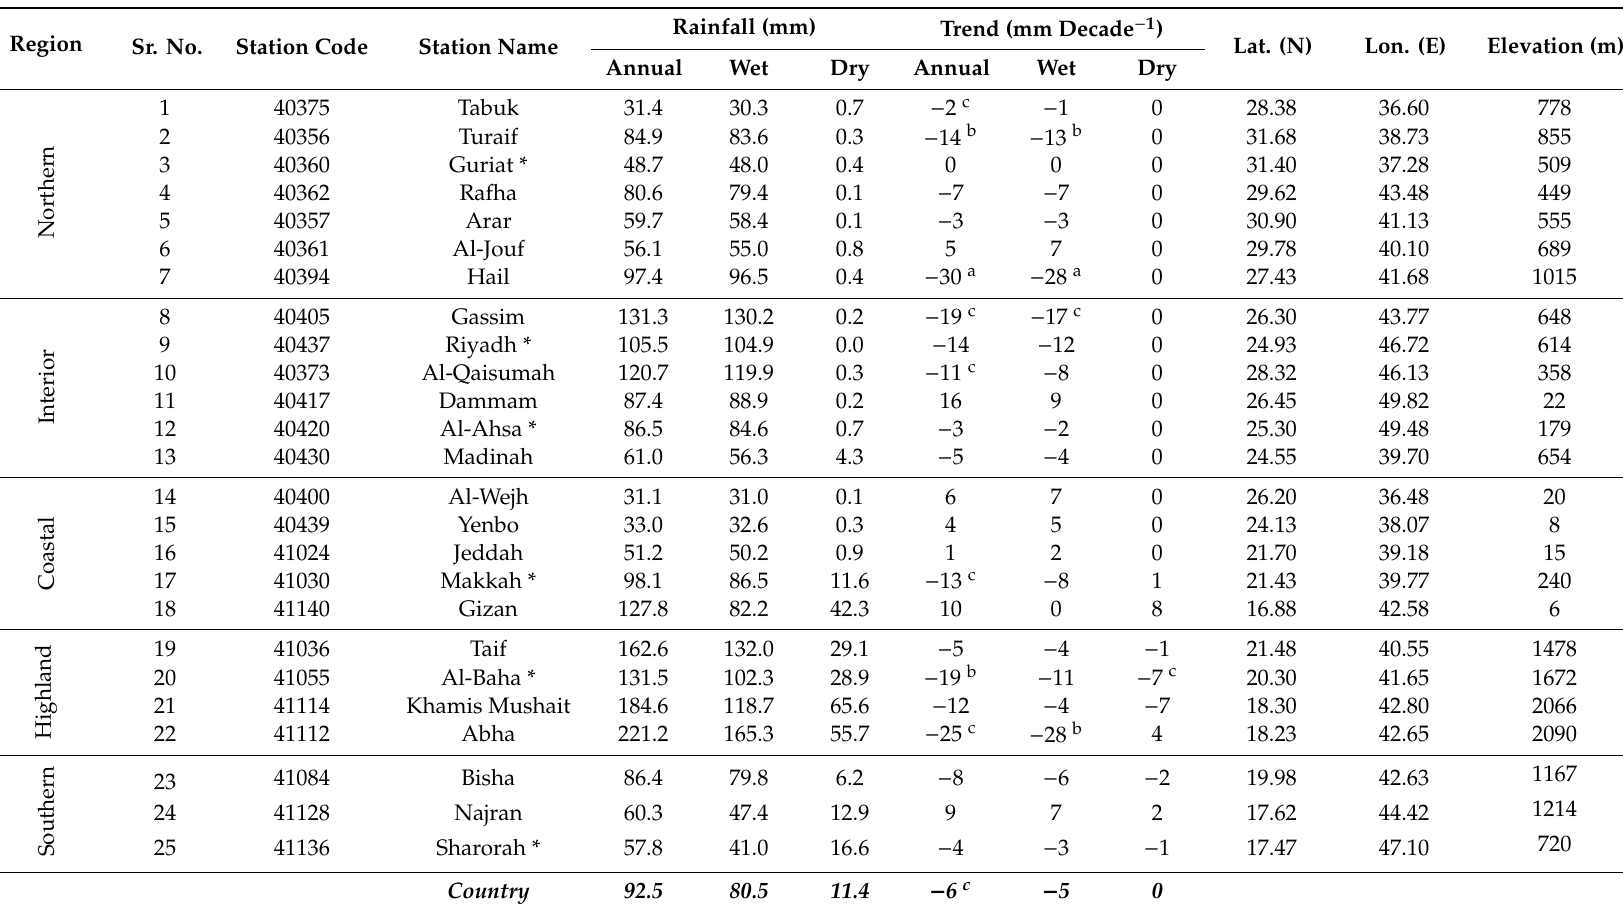
Table 1. Surface station information along with coordinates and elevations, the annual and seasonal rainfall (mm) climatology, and their trends (mm decade − 1 ). The superscripts a, b, and c represent trend significance at the 90%, 95%, and 99% confidence level, respectively. Stations are arranged in five climate regions of the